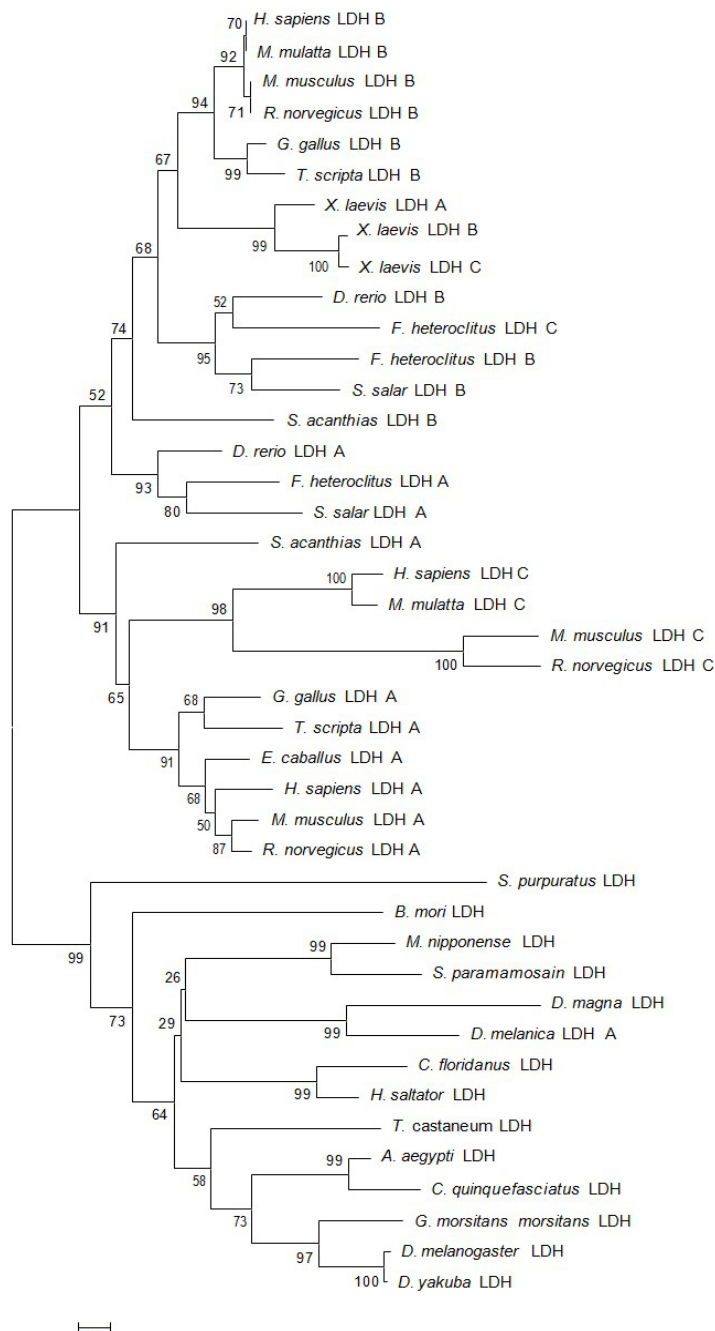
Figure 3. Phylogenetic trees were generated using the neighbor-joining method based on the alignment of amino acid sequences of LDH. The numbers shown at the branches indicate the bootstrap values (%). Sequences used in the analysis with their abbreviation and GenBank accession number are: Macrobrachium nipponense , MF033360 (this work); Homo sapiens LDH A, AAH67223; H. sapiens B, AAH71860; H. sapiens C, AAH64388; Macaca mulatta (monkey) B, XP_001085541; M. mulatta C, XP_001082436; Mus musculus (mouse) A, NP_034829; M. musculus B, NP_032518; M. musculus C, NP_038608; Rattus norvegicus (rat) A, NP_058721; R. norvegicus B, NP_058962; R. norvegicus C, NP_036727; Gallus gallus (chicken) A, NP_990615; G. gallus B, AAG48560; Trachemys scripta (pond slider) A, AAD46979; T. scripta B, AAD46980; Xenopus laevis (frog) A, NP_001081050; X. laevis B,